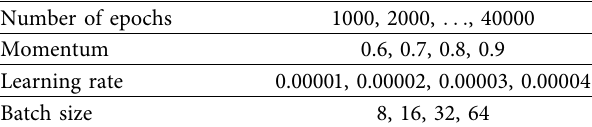
Figure 7: The performance of image restoration: (a) before restoration; (b) after restoration. Table 2: Tested values in grid search of